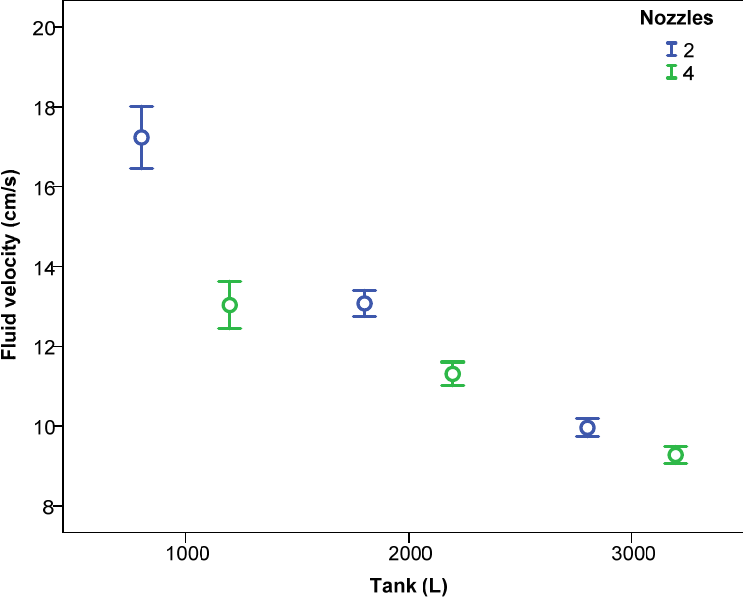
Figure 6. Fluid velocity (mean ± 95% confidence interval) according to the level of water in the tank and the number of active nozzles.